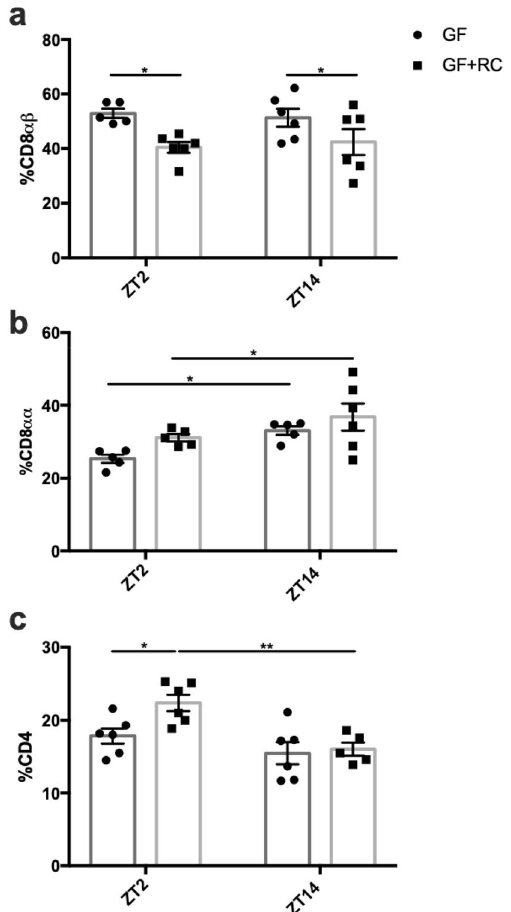
Figure 6. Time-dependent changes in SI IEL cell populations are partially restored following FMT in GF-mice. Proportions of ( a ) CD8αβ + , ( b ) CD8αα + , and ( c ) CD4 + on TCRβ + cells acquired from the SI epithelium at ZT2 and ZT14 from GF and GF-mice following FMT with RC-microbiome. n = 2–3 male and 2–3 female mice. * p < 0.05 ** p <